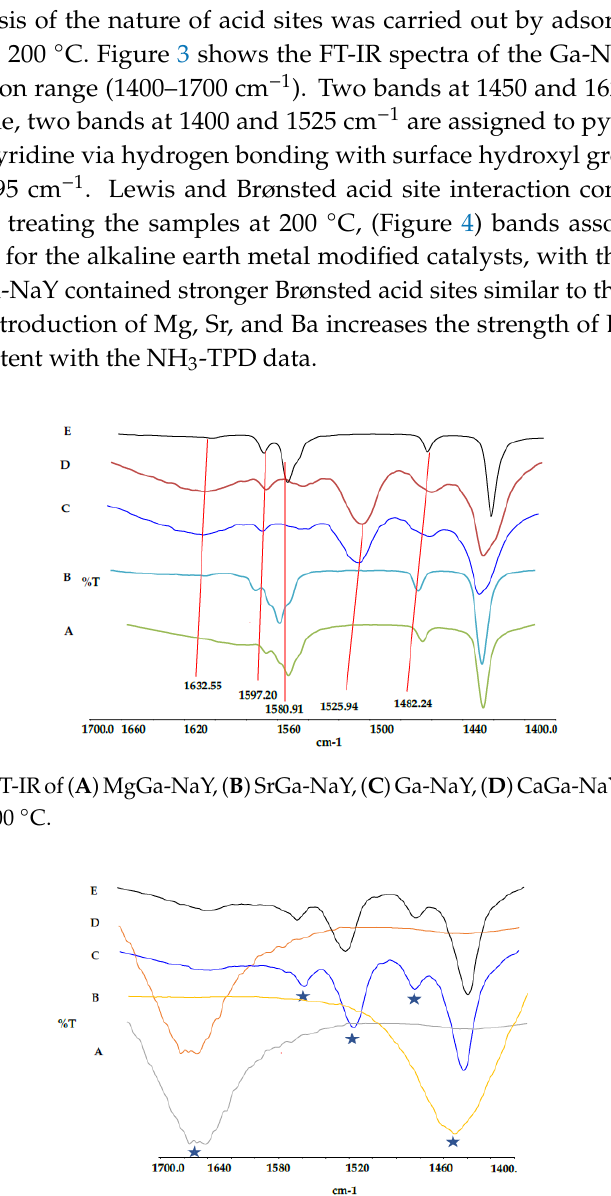
Figure4. Pyridine-FT-IRof( A )BaGa-NaY,( B )SrGa-NaY,( C )CaGa-NaY,( D )MgGa-NaYand( E )Ga-NaY Figure 4. Pyridine-FT-IR of ( A ) BaGa-NaY, ( B ) SrGa-NaY, ( C ) CaGa-NaY, ( D ) MgGa-NaY and ( E ) Ga- carried out at T = 200 ◦ NaY carried out at T = 200 o C.